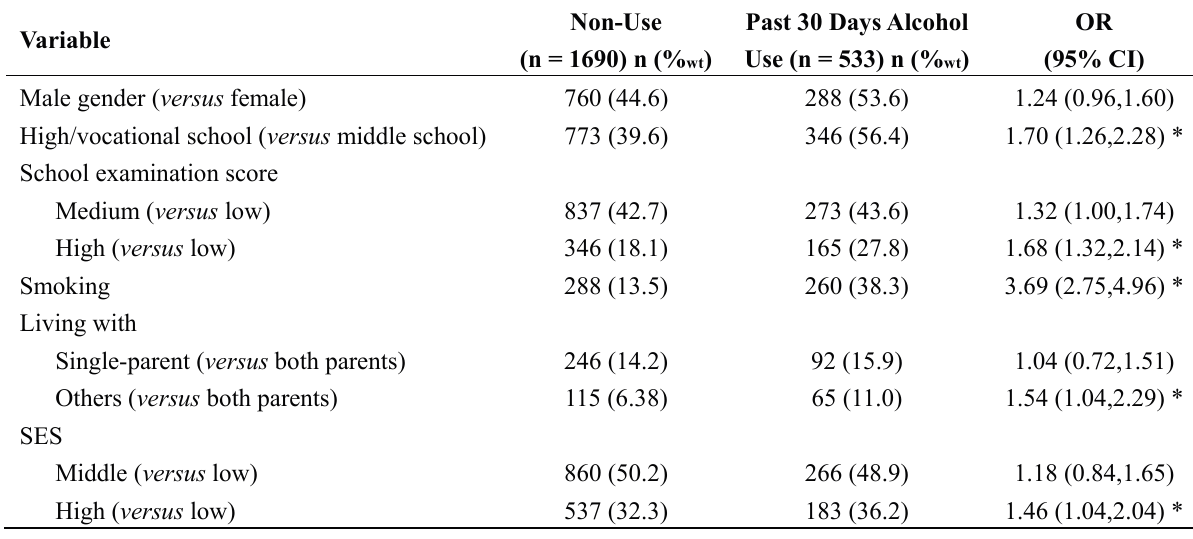
Table 1. Univariate association of demographic characteristics with past 30 days alcohol use among 2223 adolescents in